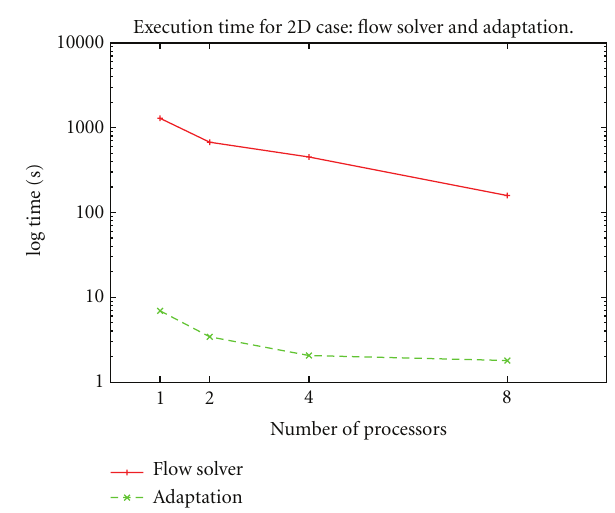
Figure 20: Execution time for flow solver and adaptation process on multiple processors. 2D NACA 0012, four adaptation